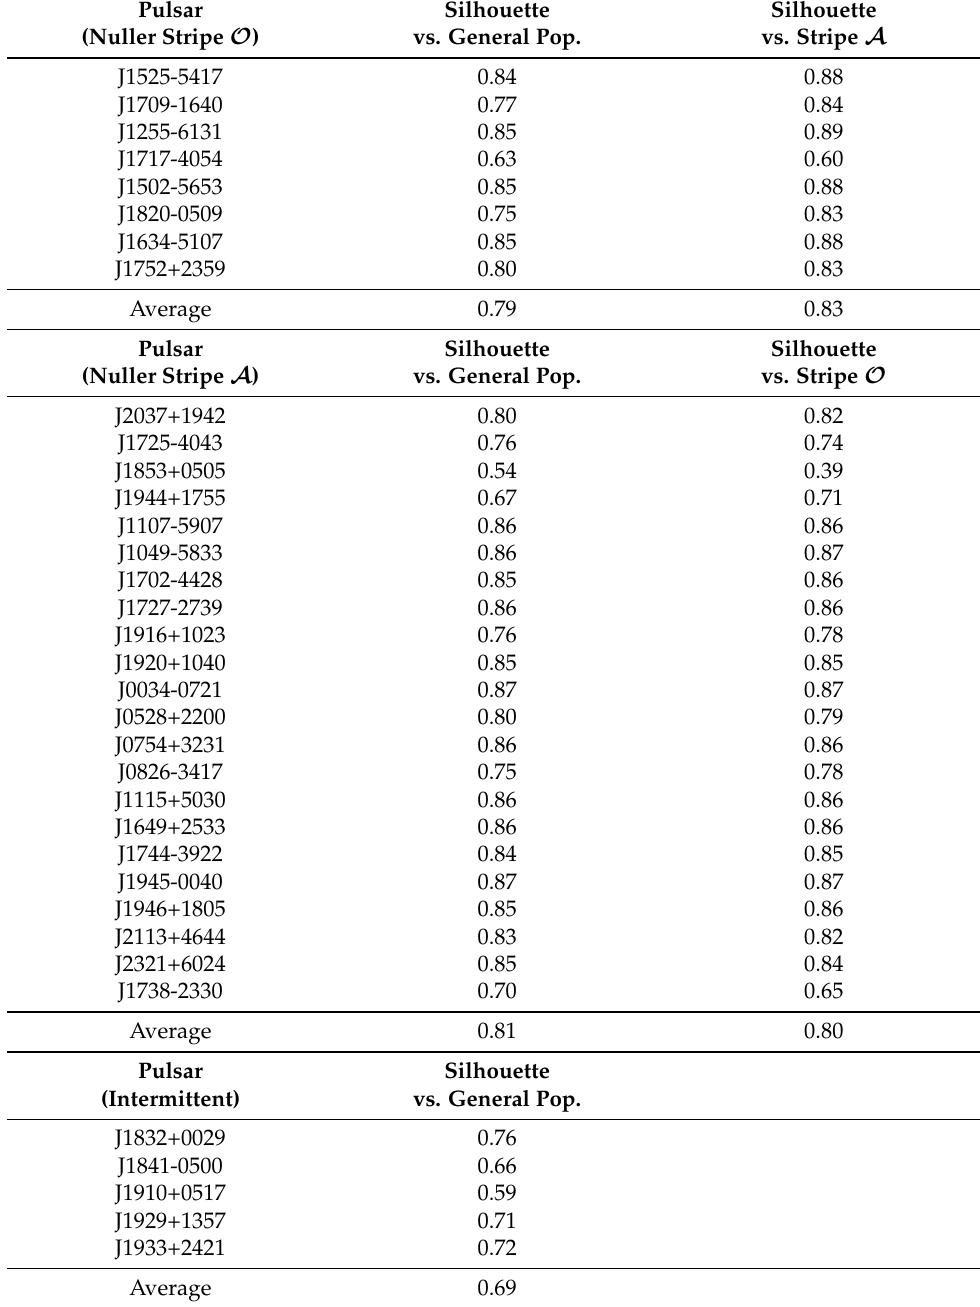
Table 1. Silhouette values indicating the statistical significance of the clustering in P of the intermit- tent pulsars and high-fraction nullers. Pulsar Silhouette Silhouette (Nuller Stripe O ) vs. General